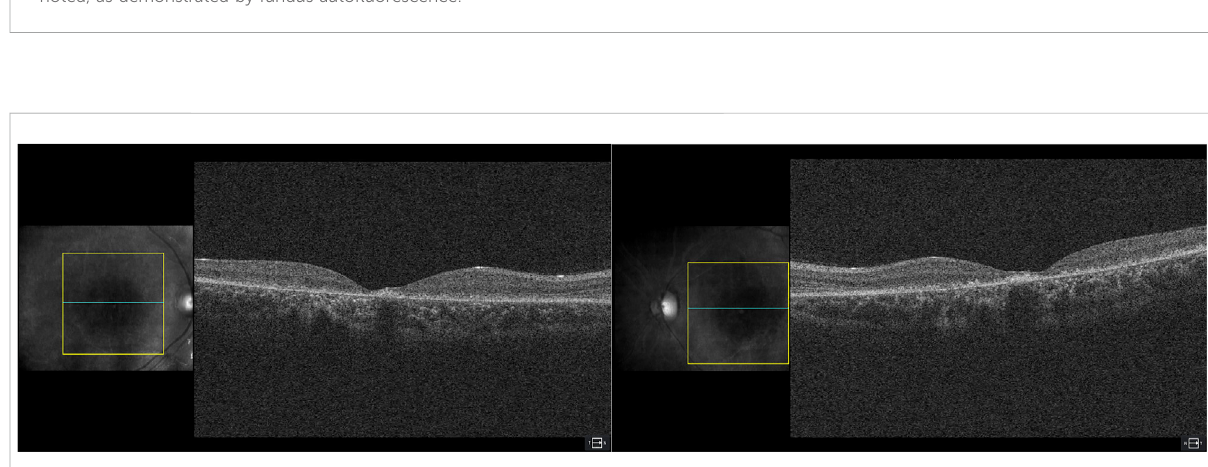
FIGURE 1 (A) Color fundus photography revealed a macular bull ’ s eye appearance with small pisciform yellow-white fl ecks scattered within the posterior pole on both eyes. (B) Fundus auto fl uorescence (FAF) revealed a central area of macular hypoauto fl uorescence along with retinal fl ecks extending centrifugally and appearing hypoauto fl uorescent in the center and hyperauto fl uorescent in the periphery. The peripapillary sparing retina should be noted, as demonstrated by fundus auto fl uorescence.